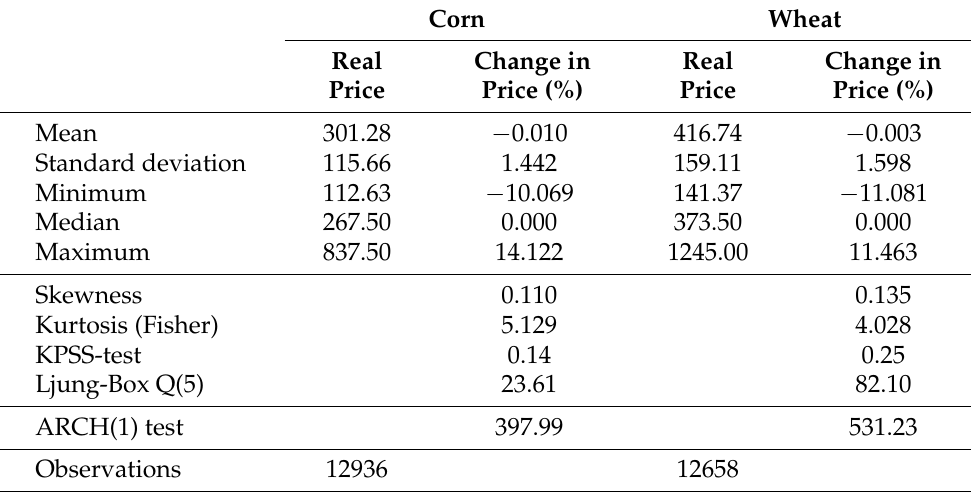
Table 1. Summary statistics for real futures prices for corn and wheat,